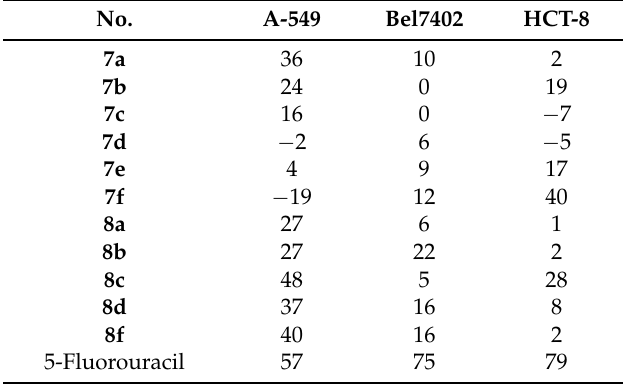
Table 1. The anticancer activity of title compounds at 5 µ g/mL (%, inhibitory). No. A-549 Bel7402 HCT-8 7a 36